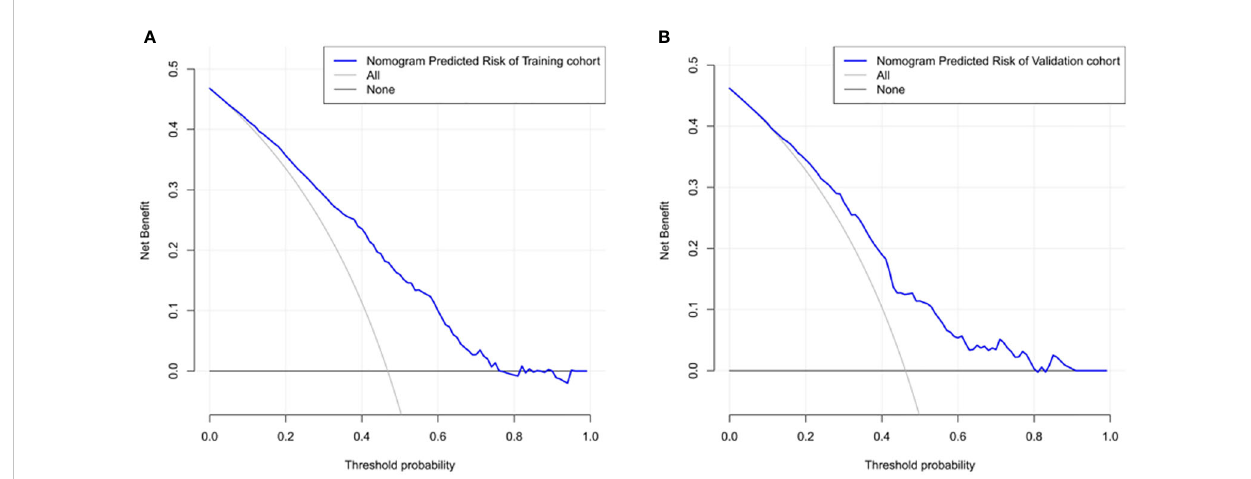
FIGURE 6 The nomogram model predicted the decision curve of carotid atherosclerosis in patients with T2DM. The y-axis measures the net return. The dotted line represents the CAD risk nomogram. The thin solid line represents the assumption that all patients are CAD. The thick solid line represents the assumption that no patients are CAD. (A) Decision curves for the training cohort show that using this nomogram predicts more bene fi t for CAD risk than intervening with the all-patient scenario or the no-intervention scenario if the threshold probabilities for patients and physicians are >2% and <76%, respectively. (B) Decision curves for the validation cohort show that using this nomogram to predict CAD risk adds more bene fi t than intervening with an all-patient regimen or a no-intervention regimen if the threshold probabilities for patients and physicians are >3% and <80%, respectively.